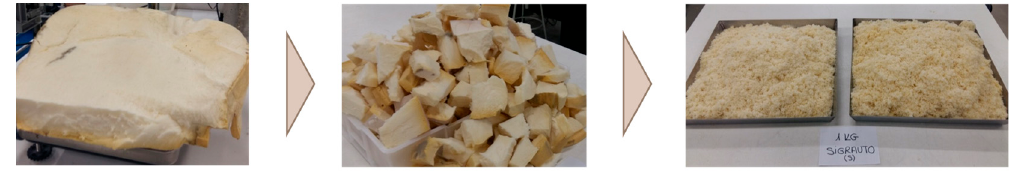
Figure 2. Previous processing of polyurethane foam waste.